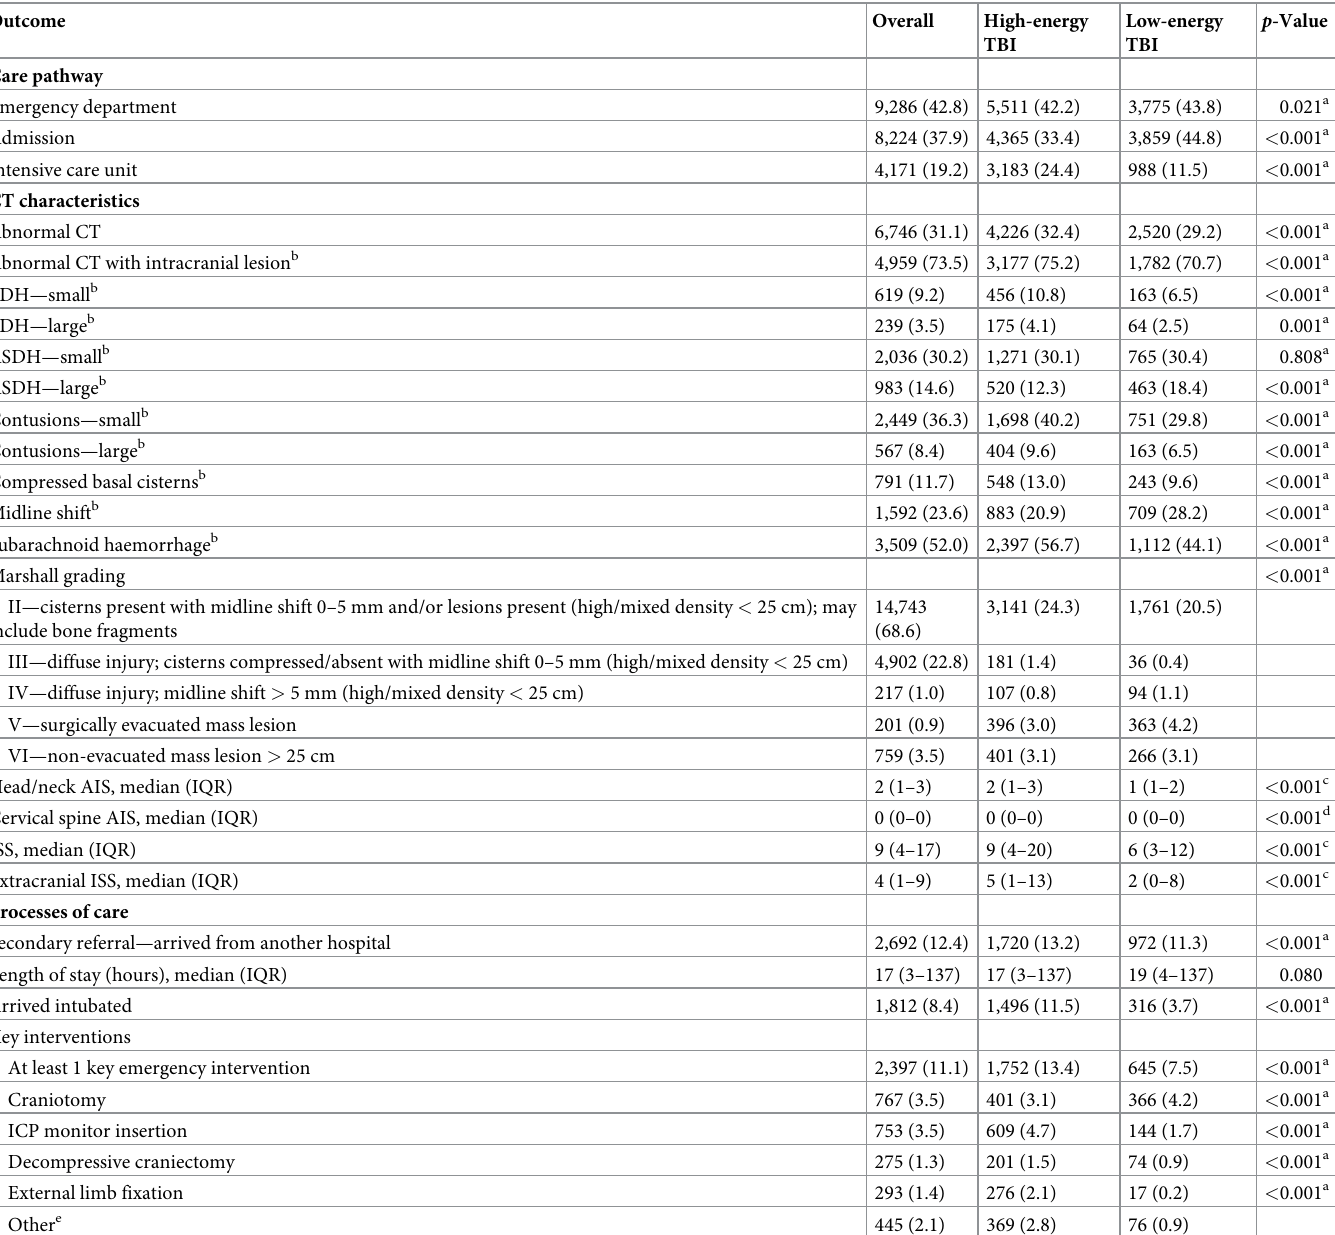
Table 2. Imaging findings, injury severity, therapeutic interventions, and care pathways of 21,681 TBI patients enrolled in the CENTER-TBI